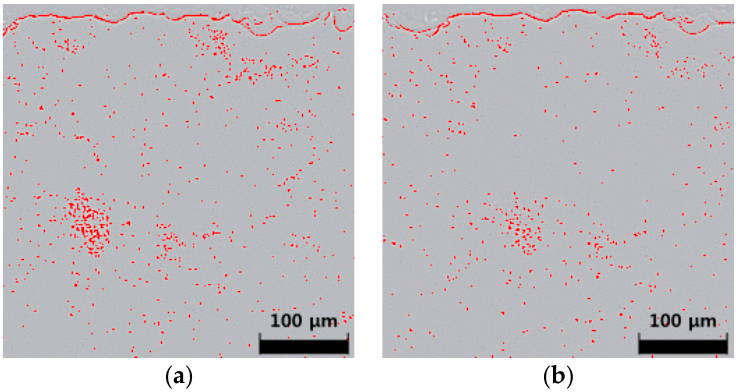
Figure 3 . Photos of a glass substrate sprayed with SiO 2 particles observed using a 10 × magnification microscope (MM-800, Nikon, Tokyo, Japan) and particle analyzer software: ( a ) immediately after the application of particles and ( b ) at one minute of air spray cleaning.